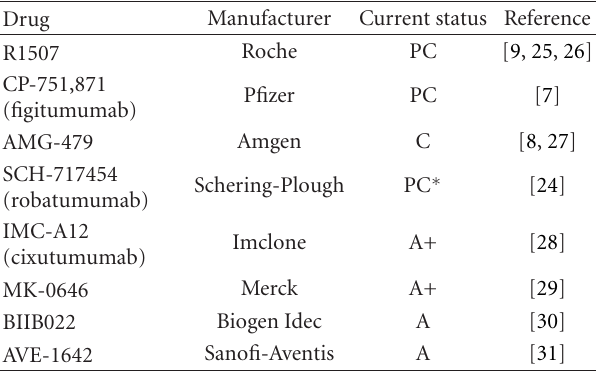
Table 1: Insulin-like growth factor 1 receptor monoclonal antibod- ies against Ewing’s